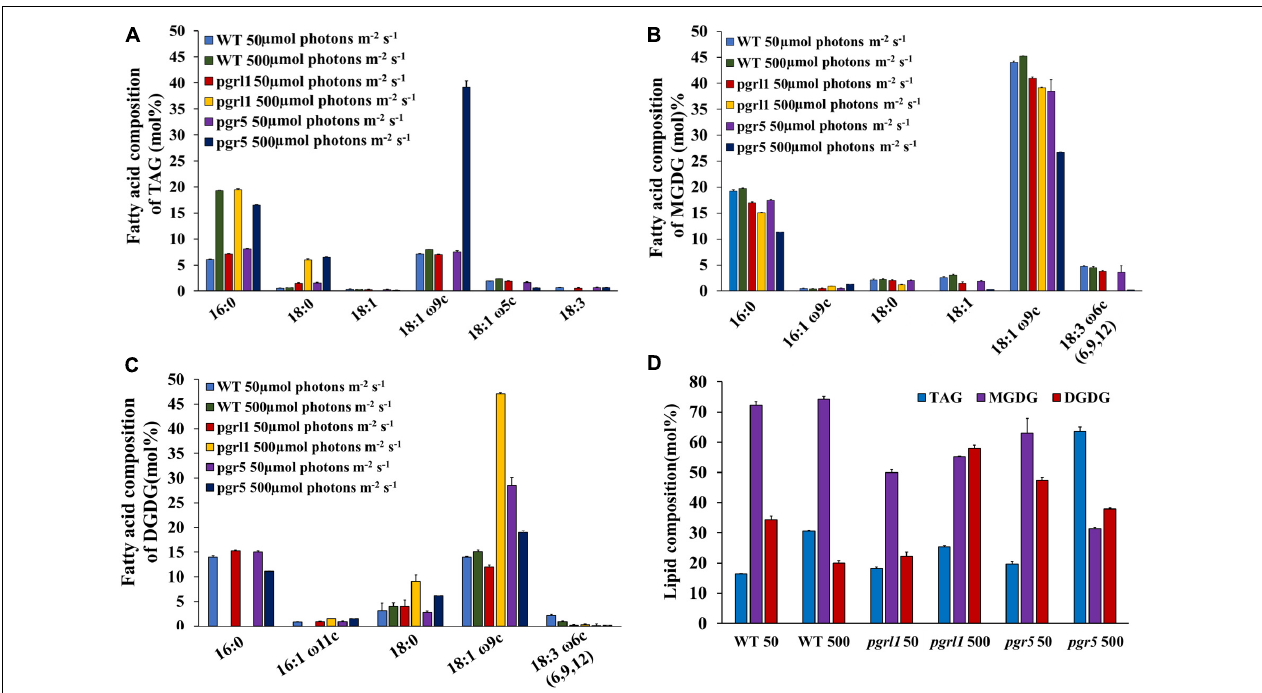
FIGURE 9 | Changes in lipid composition of C. reinhardtii cells grown under high light conditions. (A) Fatty acid composition of the TAG of WT, pgrl1, and pgr5 under normal (50 µ mol photons m − 2 s − 1 ) and high light (500 µ mol photons m − 2 s − 1 ). Fatty acids are represented as the total carbon number followed by the number of double bonds. The position of specific double bonds is indicated from the methyl end ‘ ω .’ (B) Fatty acid composition of MGDG. (C) Fatty acid composition of DGDG. (D) Changes in major lipid class in WT, pgrl1, and pgr5 under high light (500 µ mol photons m − 2 s − 1 ). In the ‘x’ axis of (D) , WT, pgrl1 and pgr5 50, WT, pgrl1 and pgr5 500, represents 50 and 500 µ mol photons m − 2 s − 1 . Averages from two independent experiments and their standard deviations are shown. TAG, triacylglycerol; PG, phosphoglyceride; DGTS, diacylglycerol-trimethyl homoserine; MGDG, monogalactosyldiacylglycerol; and DGDG, digalactosyldiacylglycerol. Averages from two replicate experiments and their standard deviations are